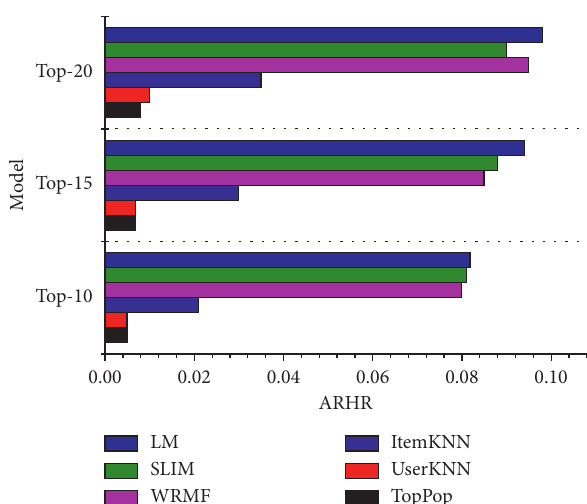
Figure 10: Comparison of ARHR